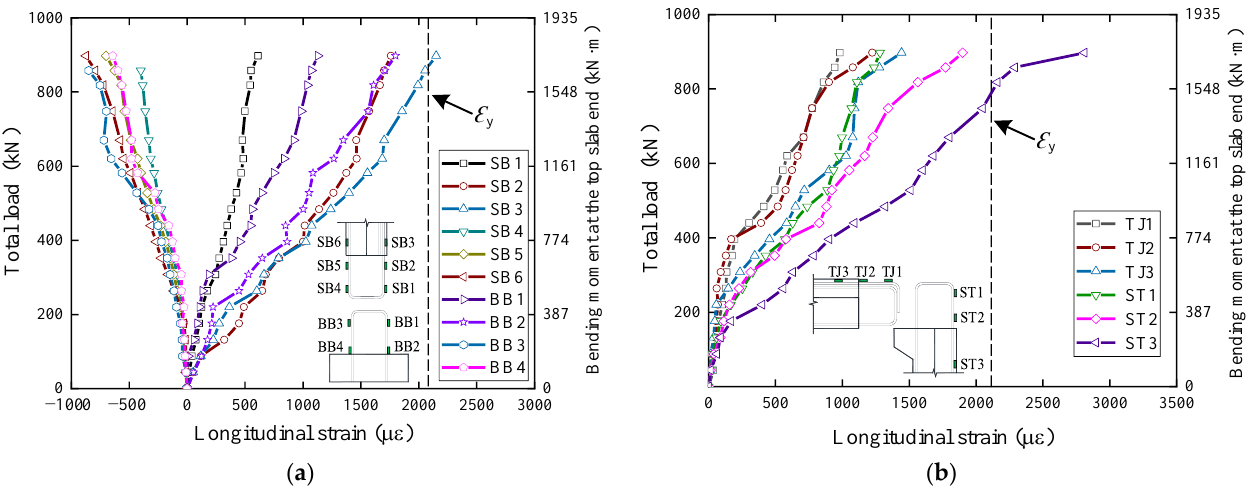
Figure 11. Strains of the U-type reinforcement at the joint: ( a ) connection of sidewalls and bottom slab and ( b ) connection of sidewalls and top slab.